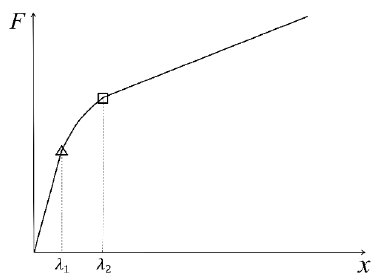
Figure 17. Backbone curve of the constitutive model.